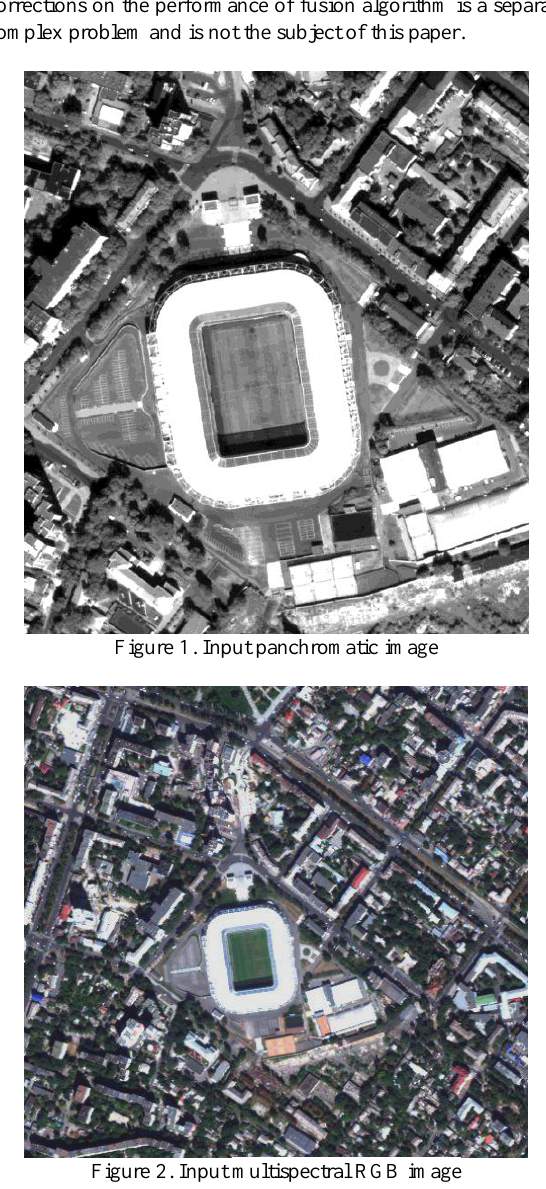
Figure 2. The MUL images are of 512*512 pixels size whereas